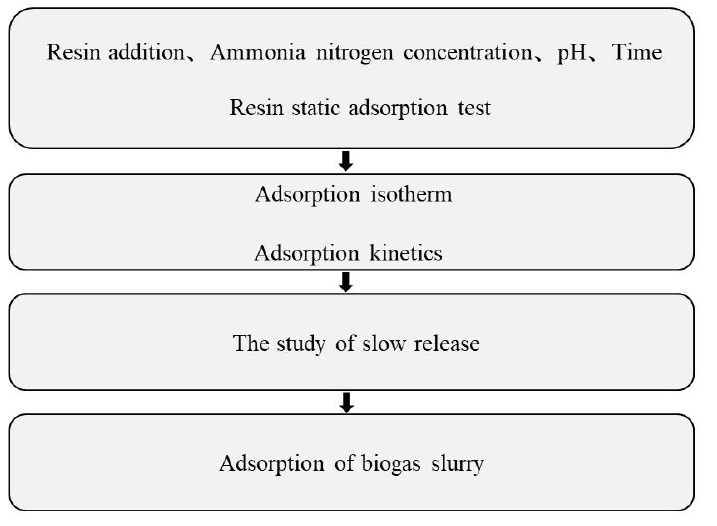
Figure 4. Schematic of the experimental procedures.